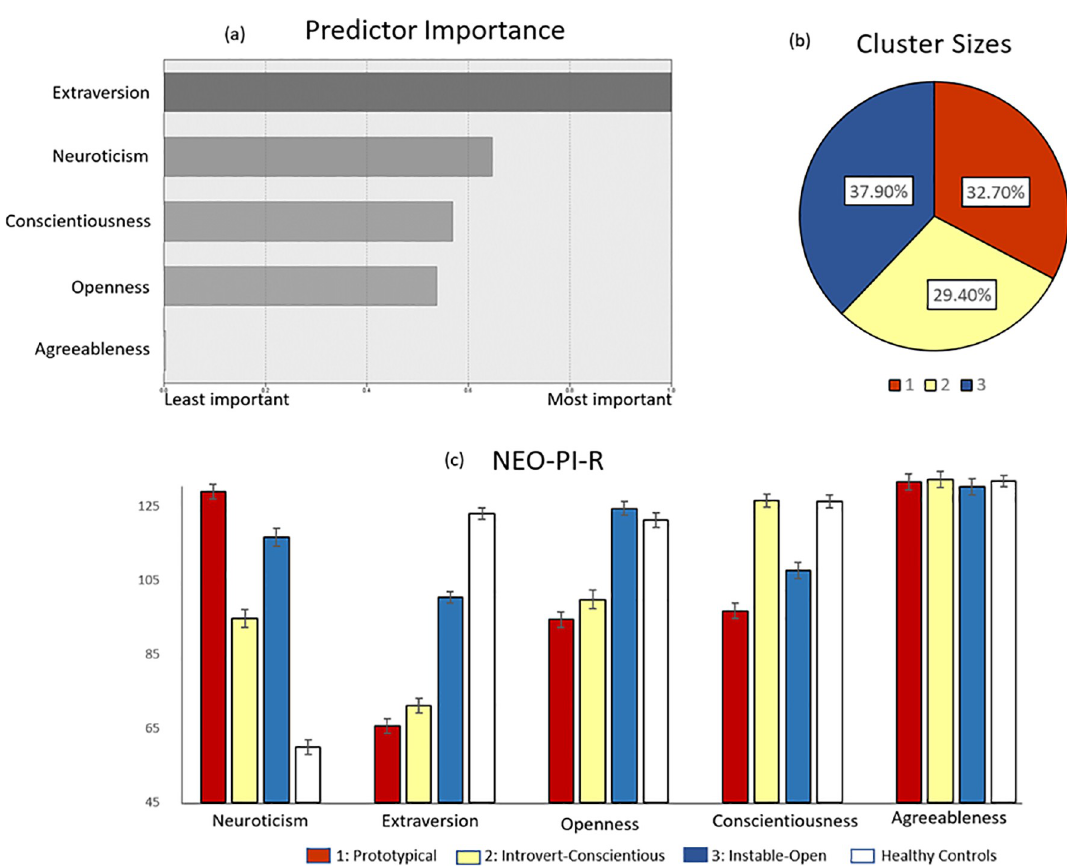
Fig 1. Cluster analysis solution. (a) Predictor importance of the five personality dimensions in the two-step cluster analysis with extraversion showing highest importance; (b) Distribution of social anxiety disorder (SAD) patients across the three resultant clusters; (c) Differences between the three SAD clusters on the five personality dimensions used as cluster variables. Healthy controls (n = 138) are also displayed for informatory purposes. Error bars represent standard errors.